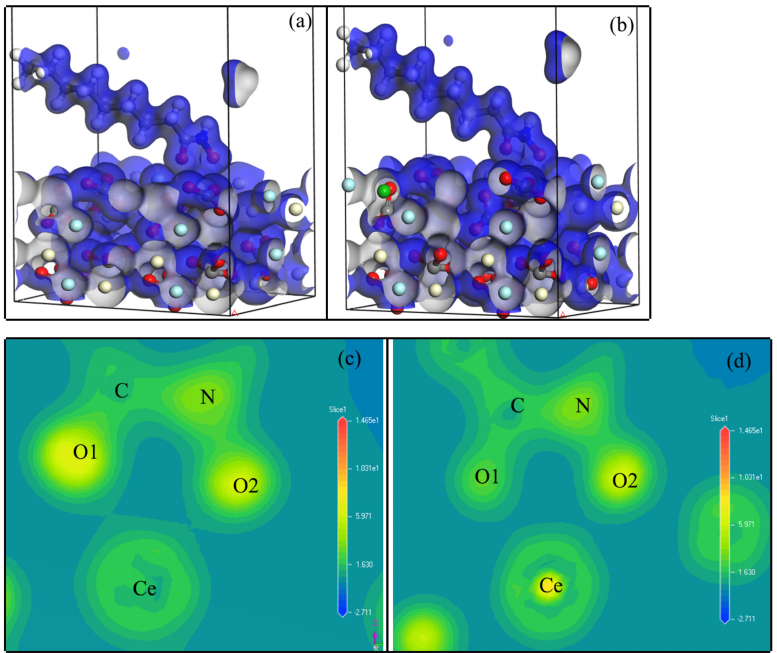
Figure 9. ( a , b ) are the charge density isoplanes adsorbed by NHA on the defective bastnaesite (100) surface; ( c , d ) are the charge densities between O—Ce atoms. ( a , c ) are the La atoms replacing Ce atoms at position 1, ( b , d ) are the La atoms replacing Ce atoms at position